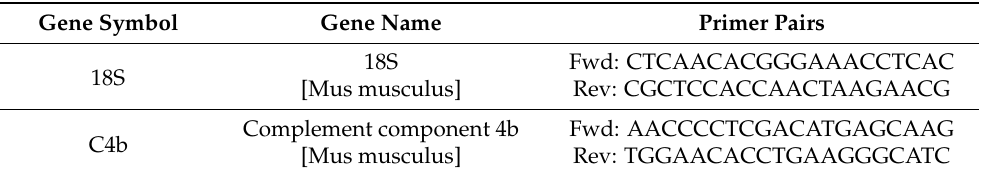
Table 4. Primers used for